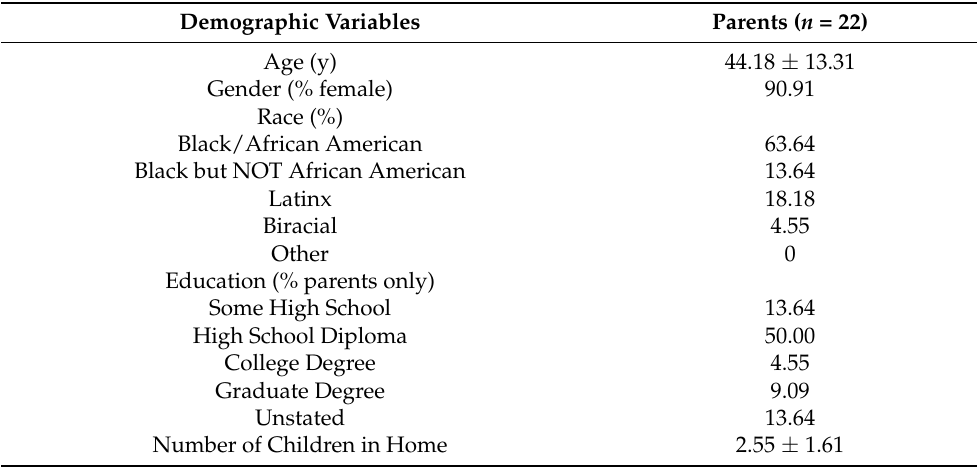
Table 3. Focus group participant demographics.